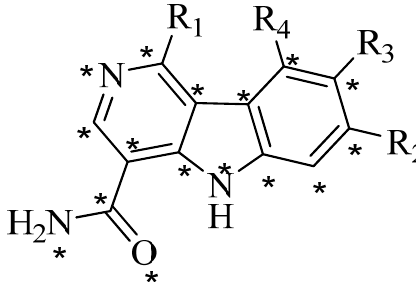
Figure 4. Structure of 5 H -pyrido[4,3-b]indol-4-carboxamide derivatives, the asterisk indicate the atoms selected as the common substructure.